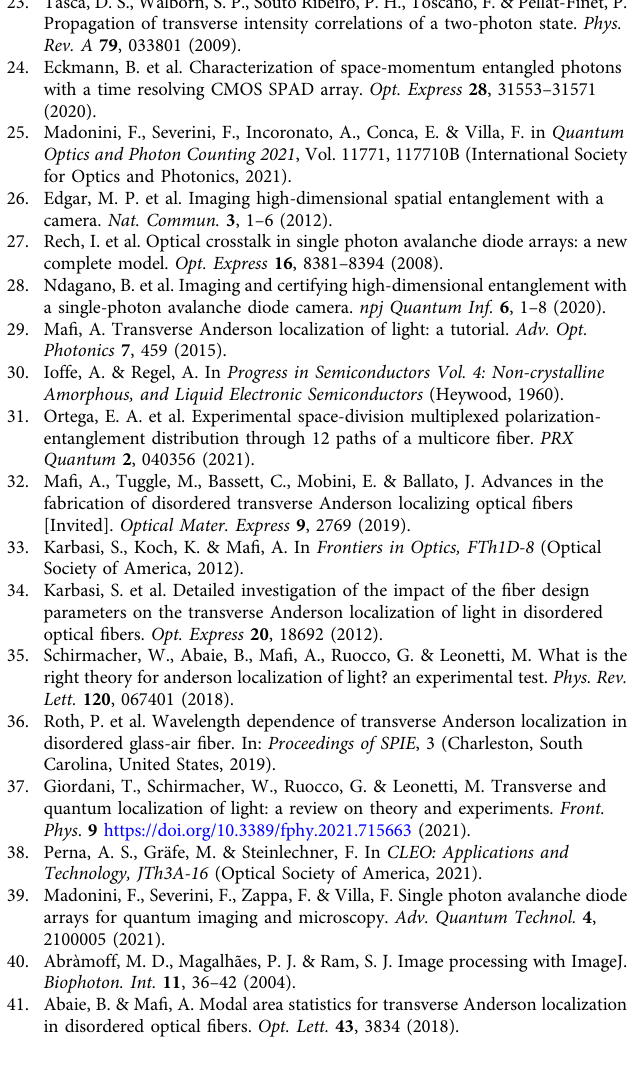
Fig. 4c – e for analyzing their similarity as described below. A CMOS camera (model IDS UI-3882LE-M-VU) with 3088 × 2076 pixels of 2.4 μ m pitch was used as imaging